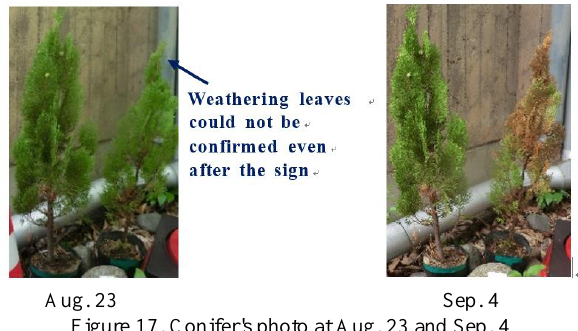
Figure 13. NDVI transition